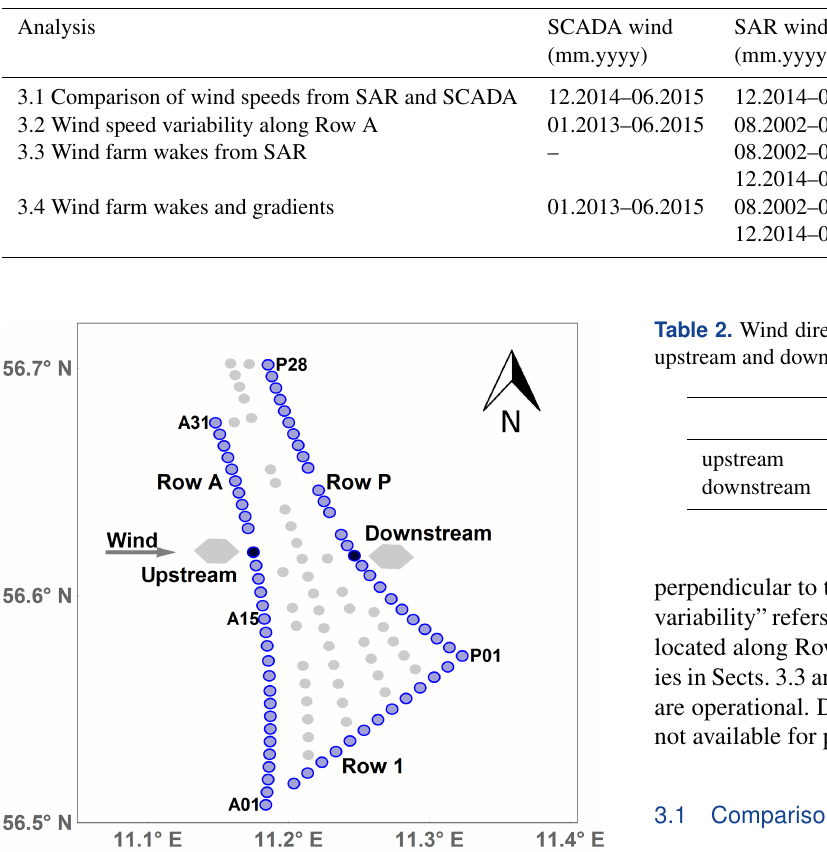
Figure 3. Sketch of the Anholt wind farm where turbines in rows A, P, and 1 are used for comparisons and marked in blue. The remain- ing turbines are located at the grey circles. The grey hexagons are examples of footprints used for extracting the average SAR wind speeds upstream and downstream of the wind turbines for an exam- ple wind direction of 270 ◦ . The turbines used for comparisons in this example are marked in black.